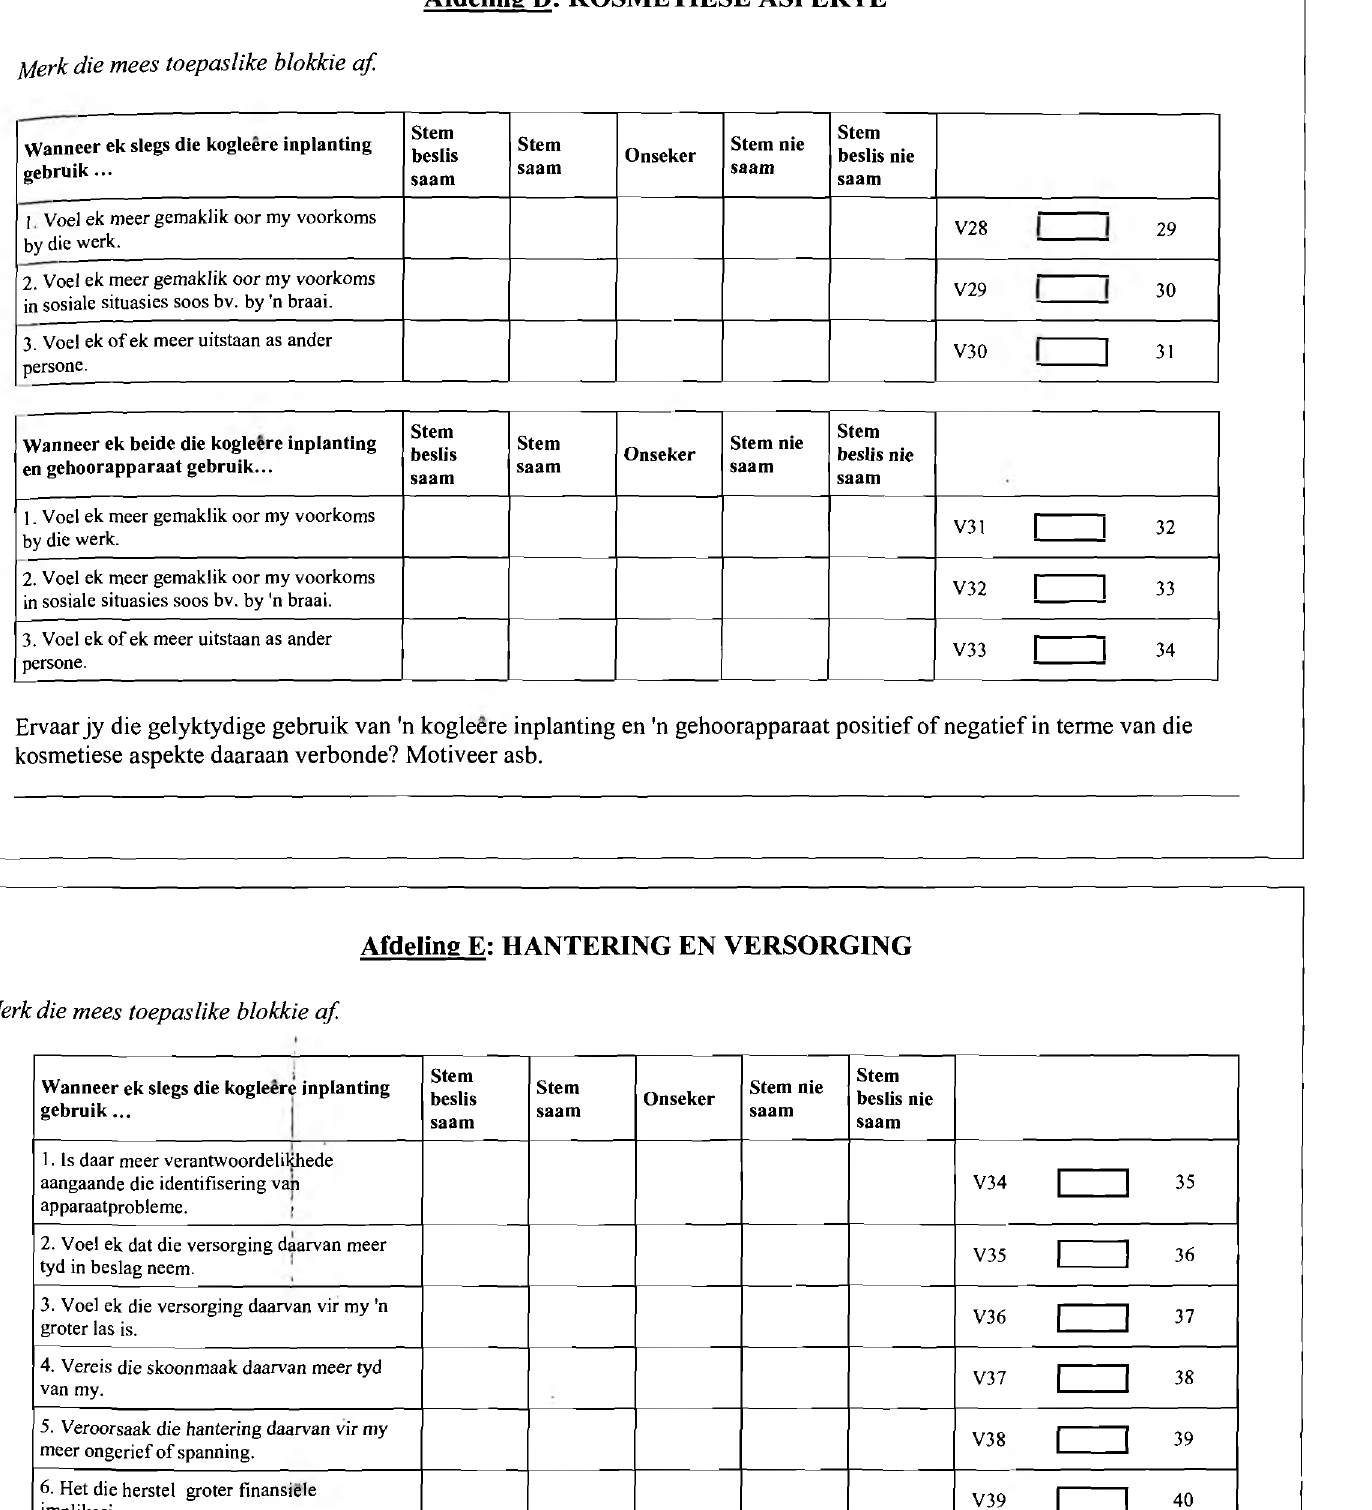
Afdeling D : KOSMETIESE